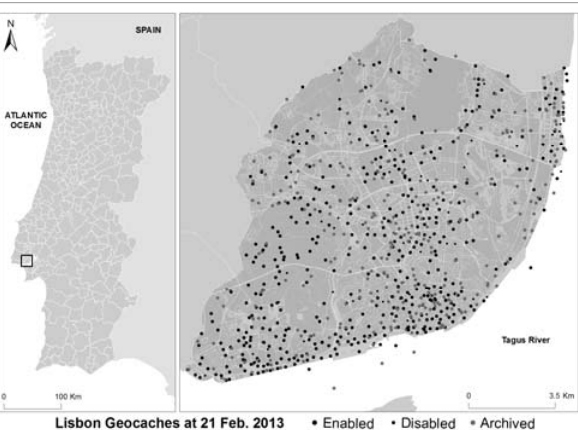
Figure 1. Study Area. Left side shows mainland Portugal and its 278 Municipalities. Right side shows Lisbon Municipality and the total 884 Geocaches that constitute the selected